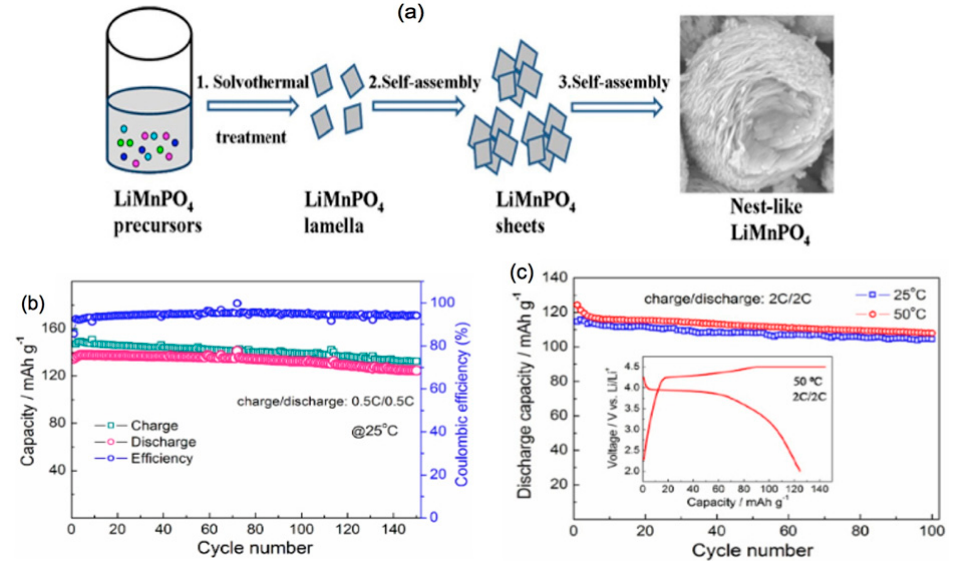
Figure 5. ( a ) Schematic illustration of the formation process of the porous, nest-like LiMnPO 4 microstructures self-assembled with nanosheets in thickness of ca. 30 nm synthesized by a solvothermal approach. ( b , c ) show the cycling performances of EC-LMP/C at 25 and 50 °C, respectively. The inset shows the charge/discharge curve at a 2 C rate. Reproduced from [145].